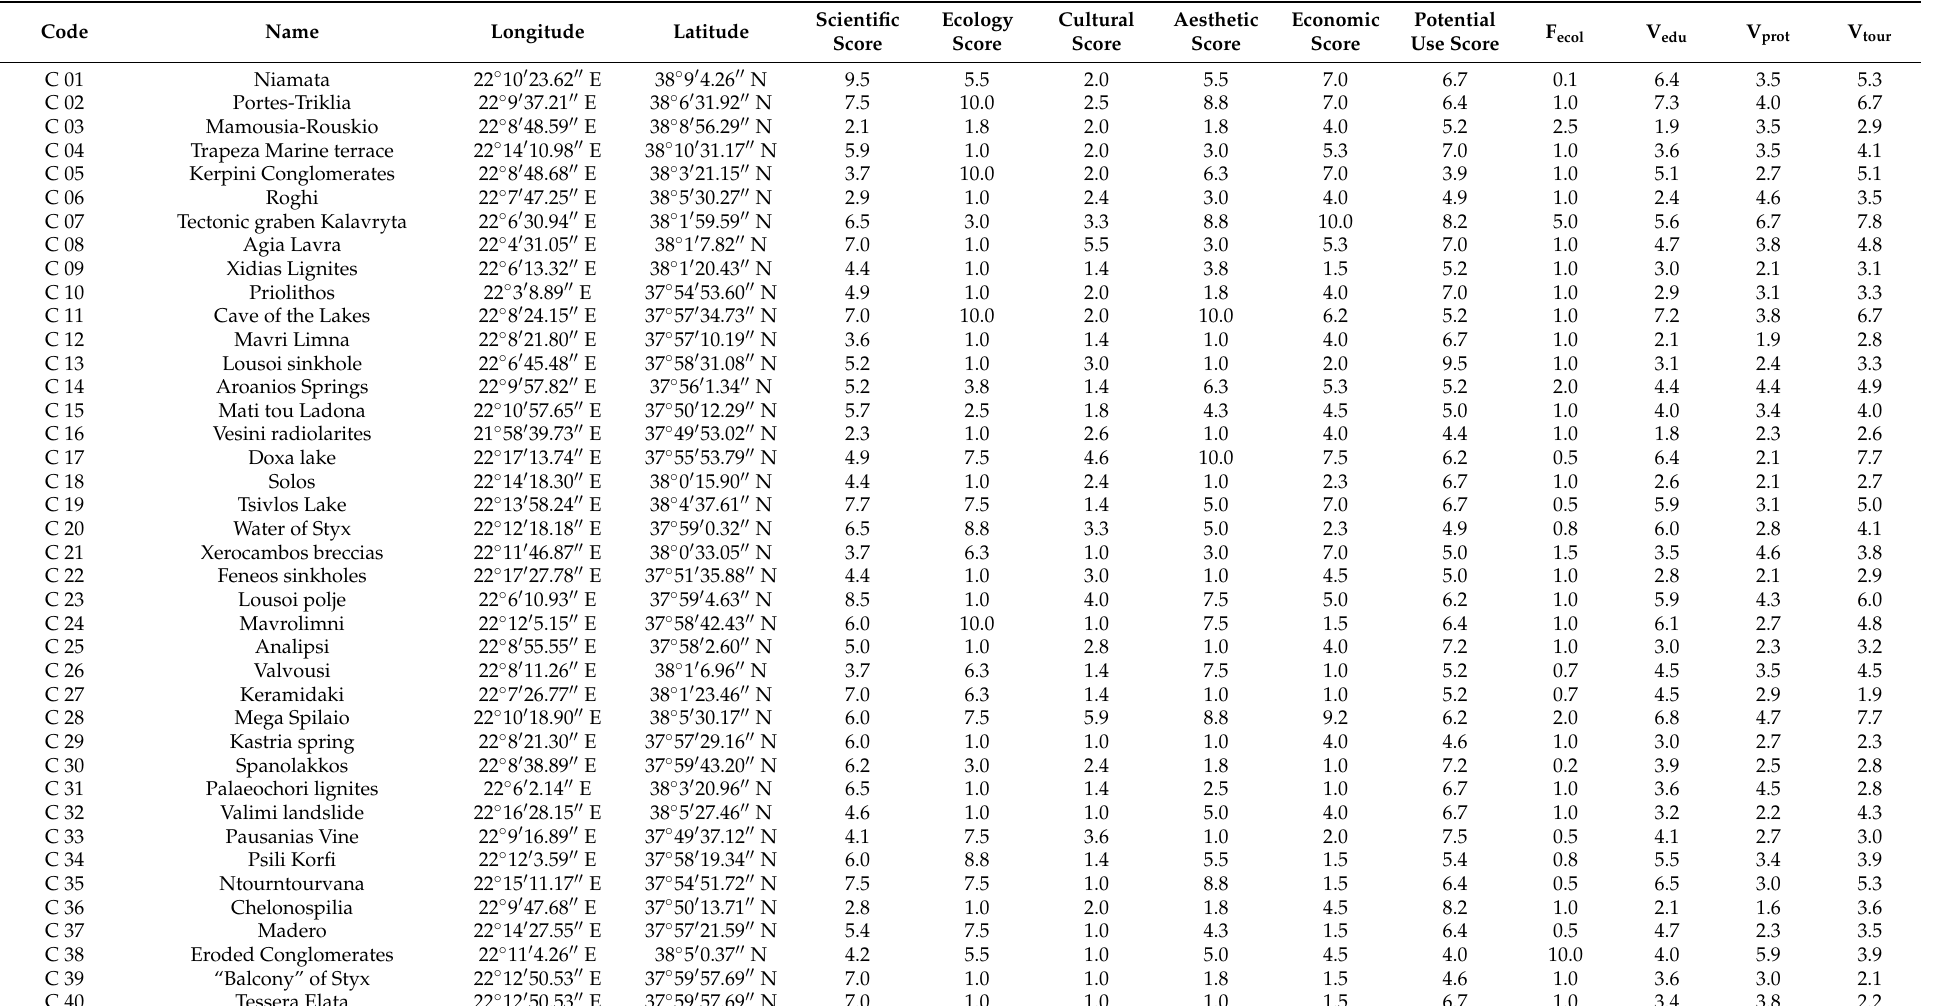
Table 4. Assessment of the results of the 40 geosites of Chelmos -Vouraikos